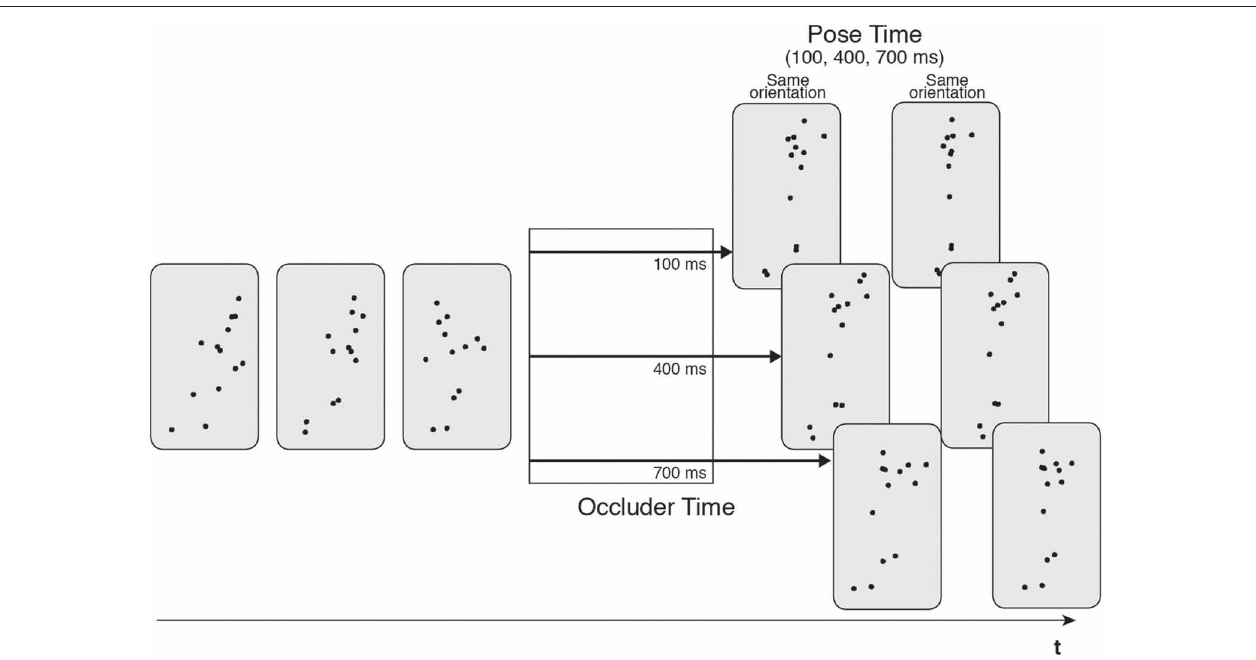
FIGURE 1 | Illustration of the stimuli utilized in Graf et al. (2007). Point light actions were presented and then occluded for a variable time (100, 400, or 700ms). Occlusion was followed by a test pose that was rotated or in the correct orientation. Pose time was also varied (100, 400, or